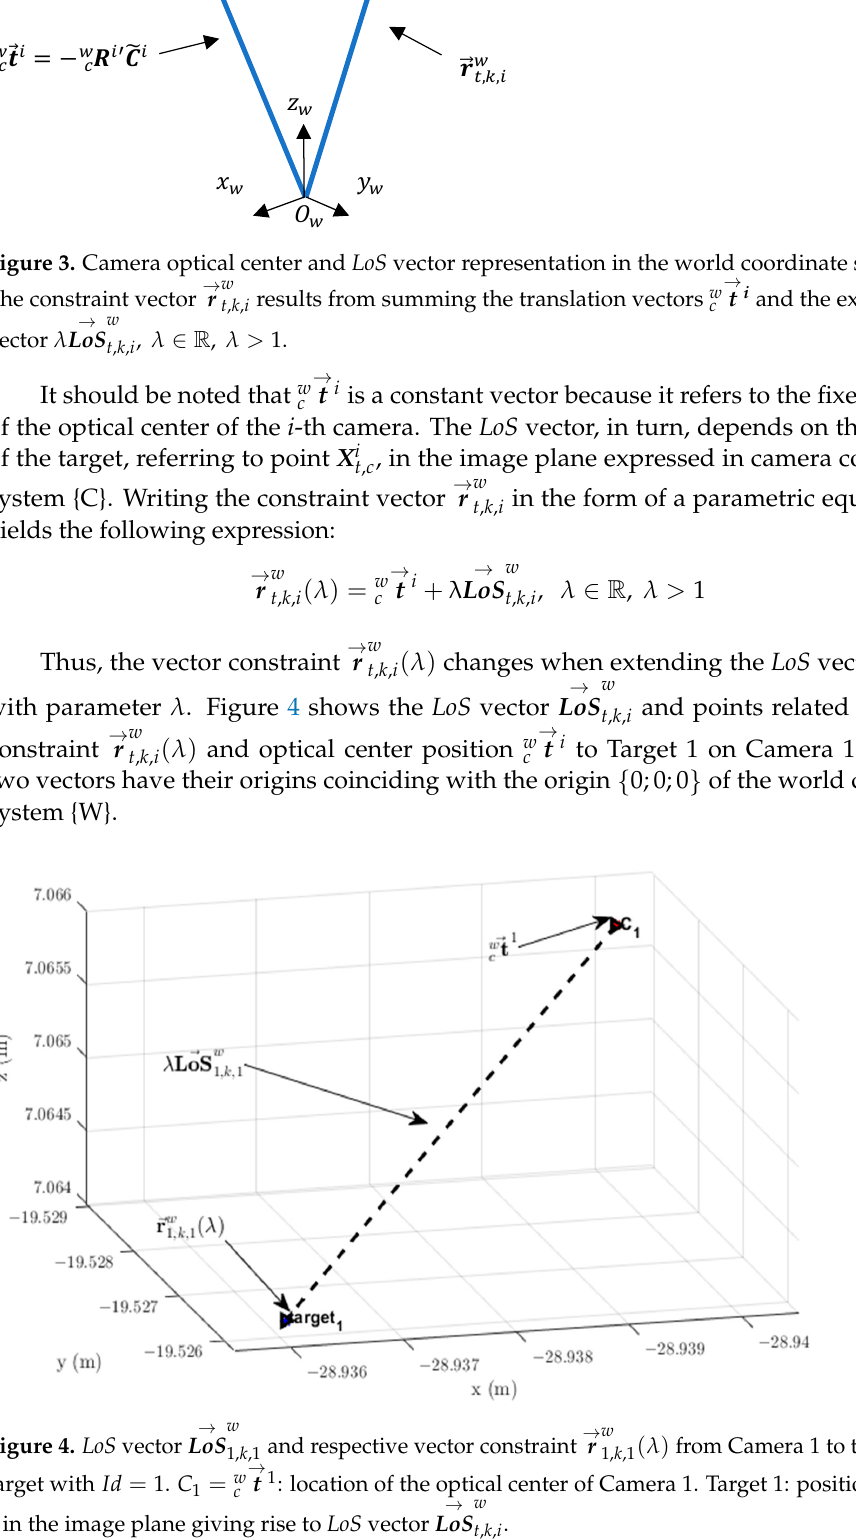
Figure 4. LoS vector 𝑳𝒐𝑺(cid:4652)(cid:4652)(cid:4652)(cid:4652)(cid:4652)(cid:4652)(cid:4652)⃗ (cid:2869),(cid:3038),(cid:2869)(cid:3050) and respective vector constraint 𝒓(cid:4652)⃗ (cid:2869),(cid:3038),(cid:2869)(cid:3050) (𝜆) from Camera 1 to the